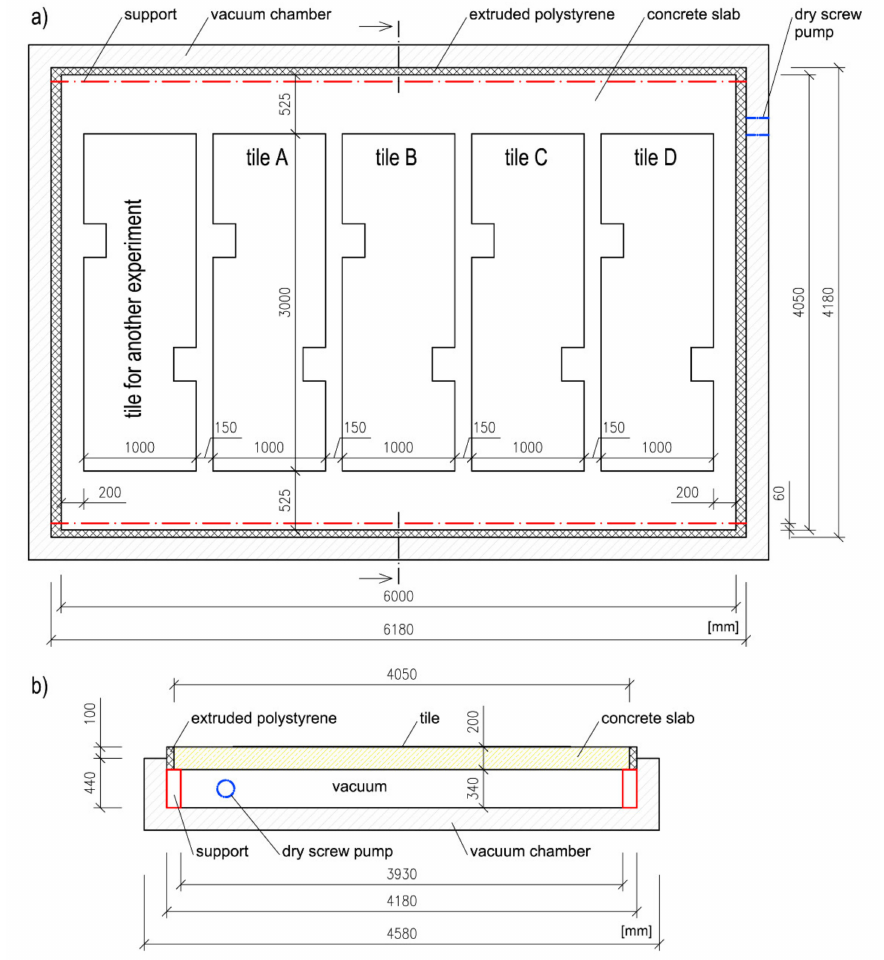
Figure 4. Diagram showing the mounting of the substrate slab with the tiles on the vacuum chamber ( a ) top view, ( b )